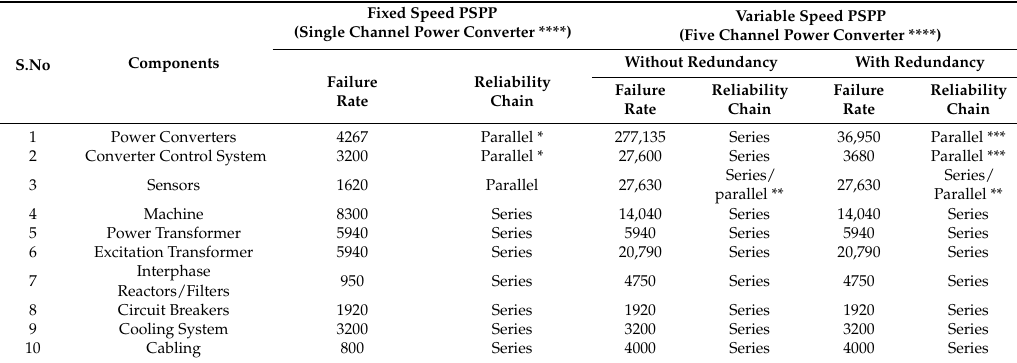
Figure 8. Failure probability of a 250-MW pumped-storage power unit. Table 7. Failure rate and reliability chain of pumped-storage power plants.